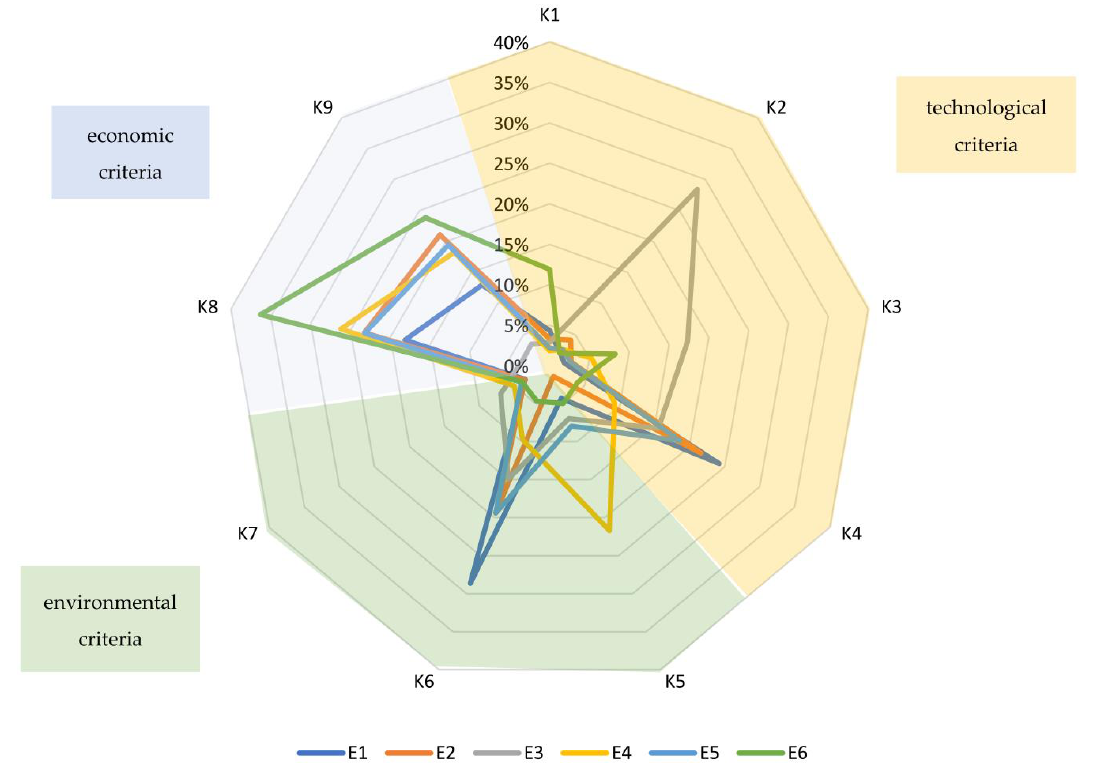
Figure 11. Expert’s preferences with regard to the criteria (relevance of the criteria in the AHP-based procedure). AHP-based